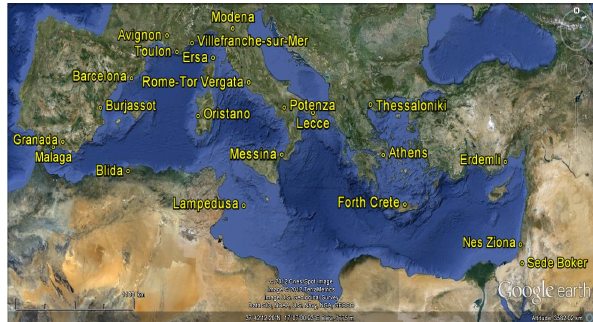
Fig. 1. Location of the 22 Mediterranean AERONET sites with long time series used in this work. Northernmost (resp. southernmost) sites are found in the western (eastern) basin.